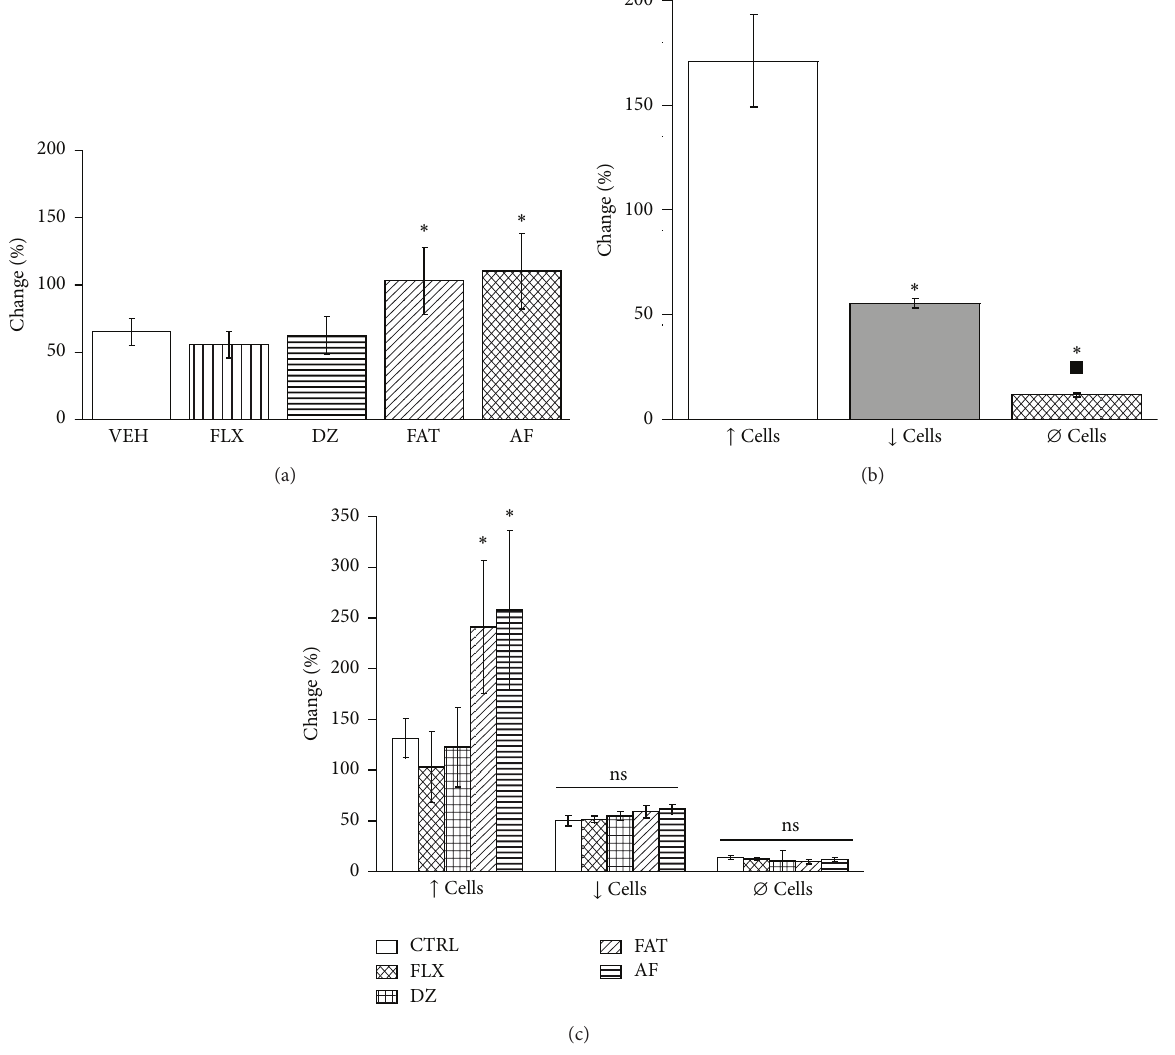
Figure 6: (a) Global percent change in the firing rate of lateral septal neurons in the different treatment groups. Only the FAT mixture and AF produced a significant change in firing rate after amygdala stimulation. (b) Percent change in neuronal firing rate in septal neurons based on the type of response. ↑ cells displayed the highest change in firing rate. (c) Only ↑ cells significantly changed their firing rate and only in the AF and FAT groups ( ∗ 𝑃 ≤ 0.05 , SNK). See Figure 2 for